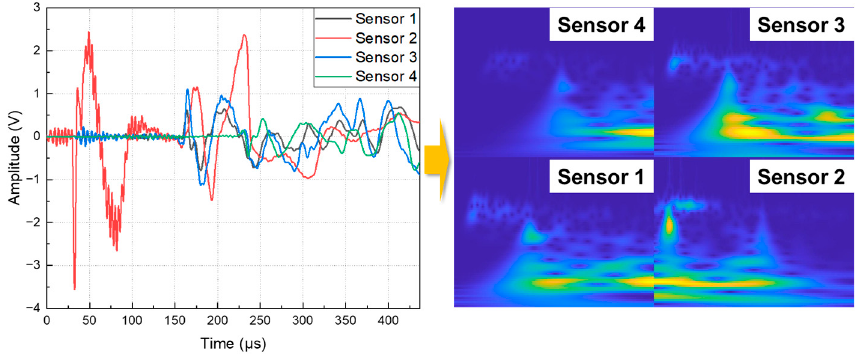
Figure 5. The construction process of the input image of the deep learning model.